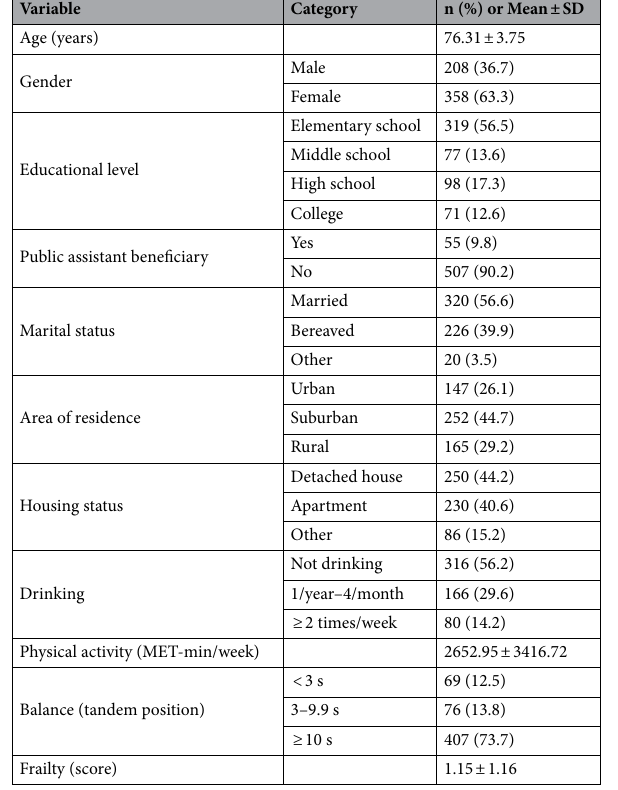
Table 1. Participants’ baseline characteristics (N = 566). SD, standard deviation; MET, metabolic equivalent.